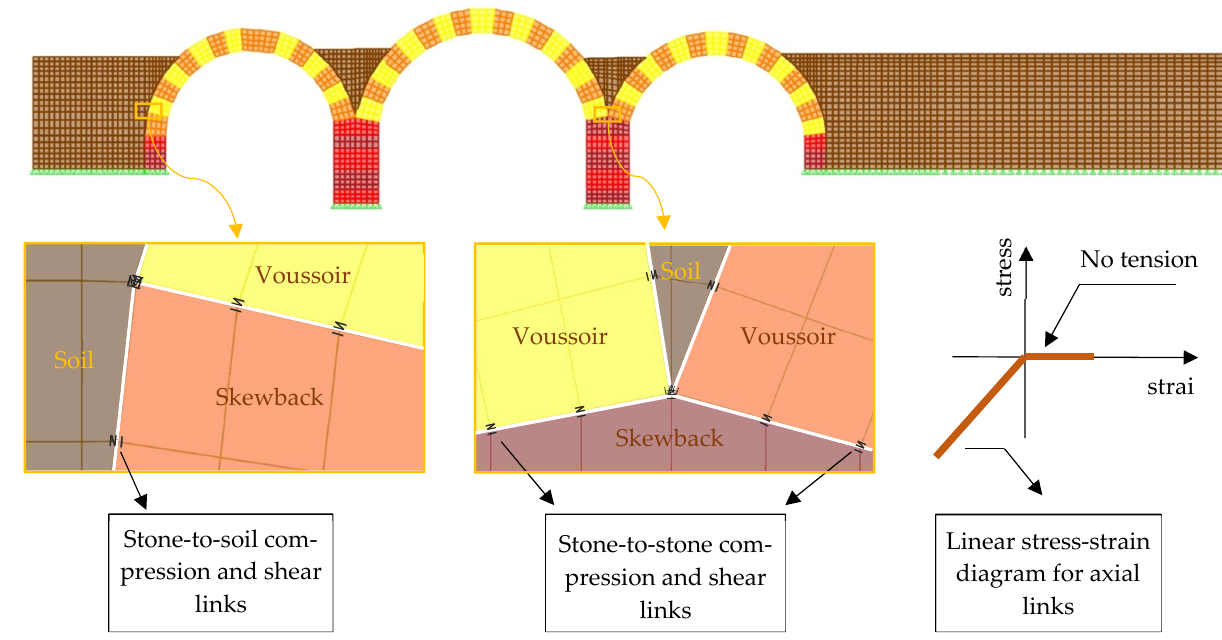
Figure 10. Numerical model details of the case study bridge.